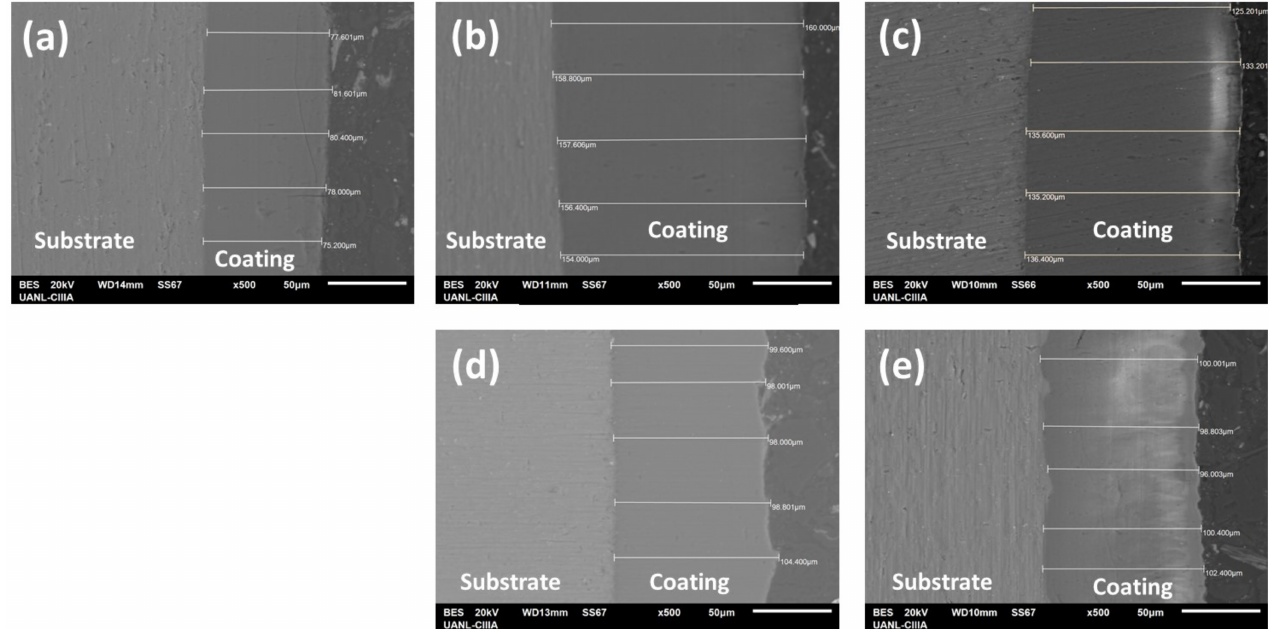
Figure 4. SEM Cross-Sectional Micrographs of the AA6061 Anodized a 4.5 A/dm 2 in Different Bath: ( a ) 4.5A C0M S2M, ( b ) 4.5A C1M S5, ( c ) 4.5A C1M S10, ( d ) 4.5A C2M S5 and ( e ) 4.5A C2M